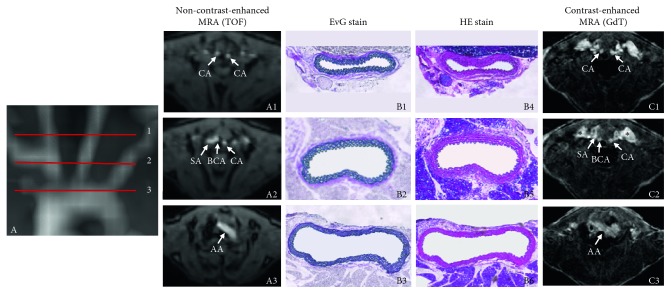
Visualization of the head/neck vasculature in a C57BL/6J mouse by MR angiography on a clinical 3T MR system. Images demonstrate the visualization of aorta (A3, B3, B6, C3), brachiocephalic artery (A2, B2, B5, C2), and carotid artery (A1, B1, B4, C1) in a C57BL/6J mouse by in vivo MR angiography on a clinical 3T MR system. Non-contrast-enhanced MR angiogram (TOF, A1-3) and contrast-enhanced MR angiogram (GdT, C1-3) in direct comparison to the associated histology of the arterial vessels (B). It must be highlighted that using an intravascular contrast agent, both arteries and adjacent veins are imaged of a high signal. The maximum intensity projection of the non-contrast-enhanced MR angiogram (A) indicates the location of transverse slices and vessels based on the red lines (1 = carotid artery, 2 = brachiocephalic artery, and 3 = aorta). Corresponding ex vivo histological sections (B1–B6), Elastica van Gieson (EvG) stain (B1, B2, B3), and hematoxylin eosin (HE) stain (B4, B5, B6) are demonstrated. CA: carotid artery, SA: subclavian artery, BCA: brachiocephalic artery, AA: aortic arch.